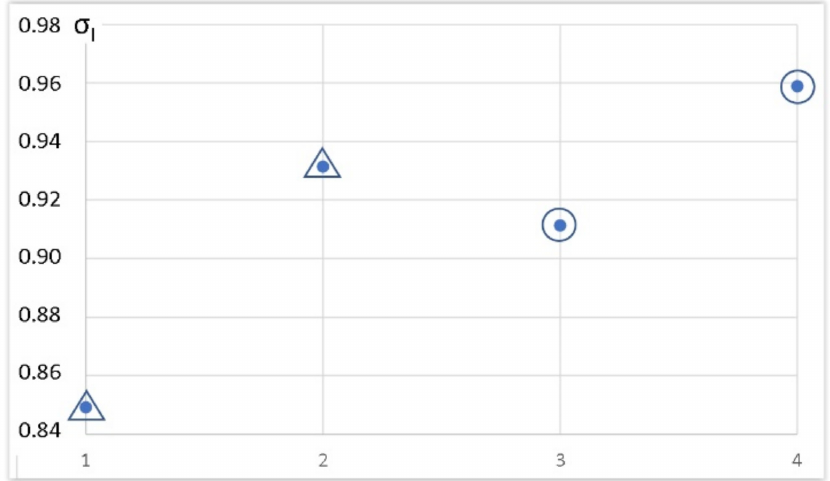
Figure 17. The calculated indicator σ I for consoles with selected locks: 1—arrow lock; 2—arrow lock with dash; 3—semicircular lock; 4—semicircular lock with dash.